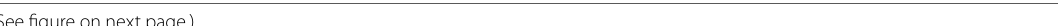
respectively(See figure on next Fig. 2 3D structure and the Ramachandran plot of the recombinant protein structure before and after. A Tertiary structure generated by the Phyre2 server. B Ramachandran plot for 3D structure generated by Phyre2 showed 86.2% of the residues in favored regions, 9.1% in allowed regions, and 2.6% in disallowed regions. C Representing the refined tertiary structure obtained by the GalaxyRefine server. D Ramachandran plot for the 3D structure generated by GalaxyRefine showed 86.6%, 12.5%, and 0.3% of the residues in favored, allowed, and disallowed regions,